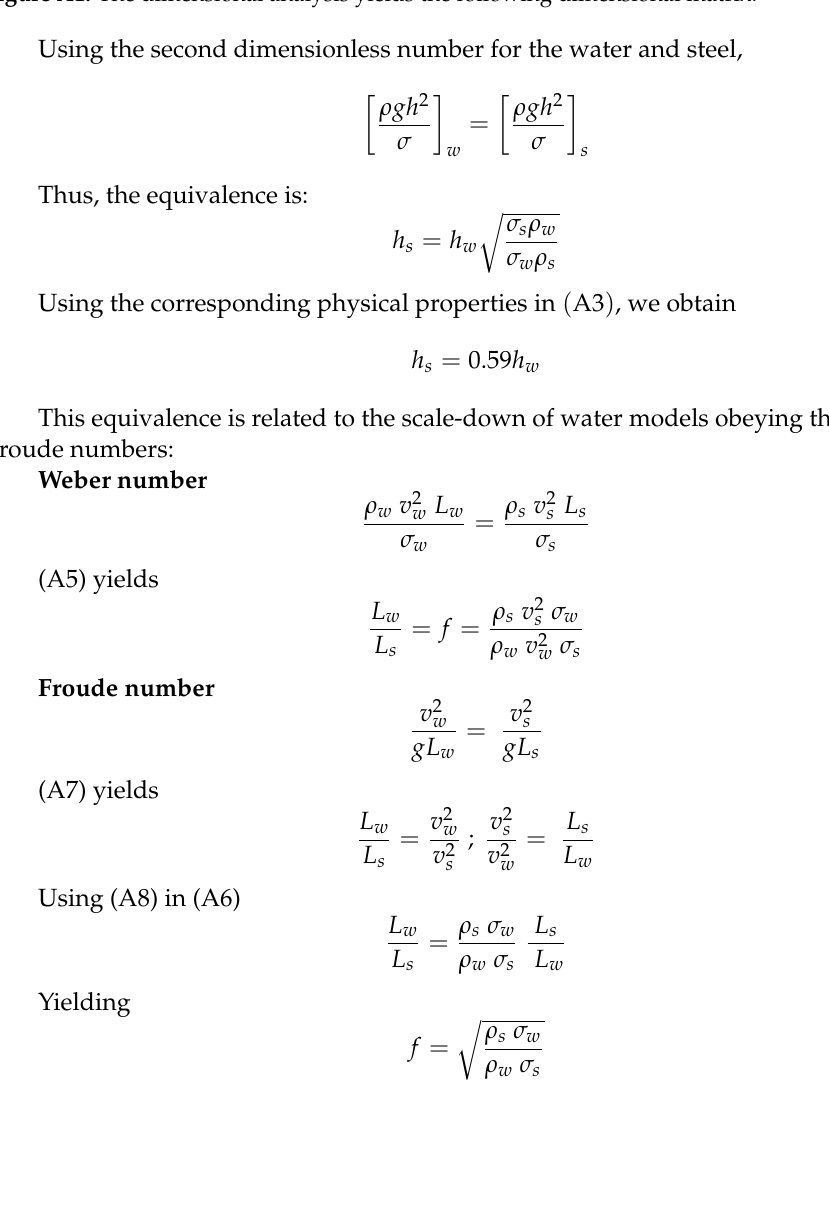
Figure A1. The dimensional analysis yields the following dimensional